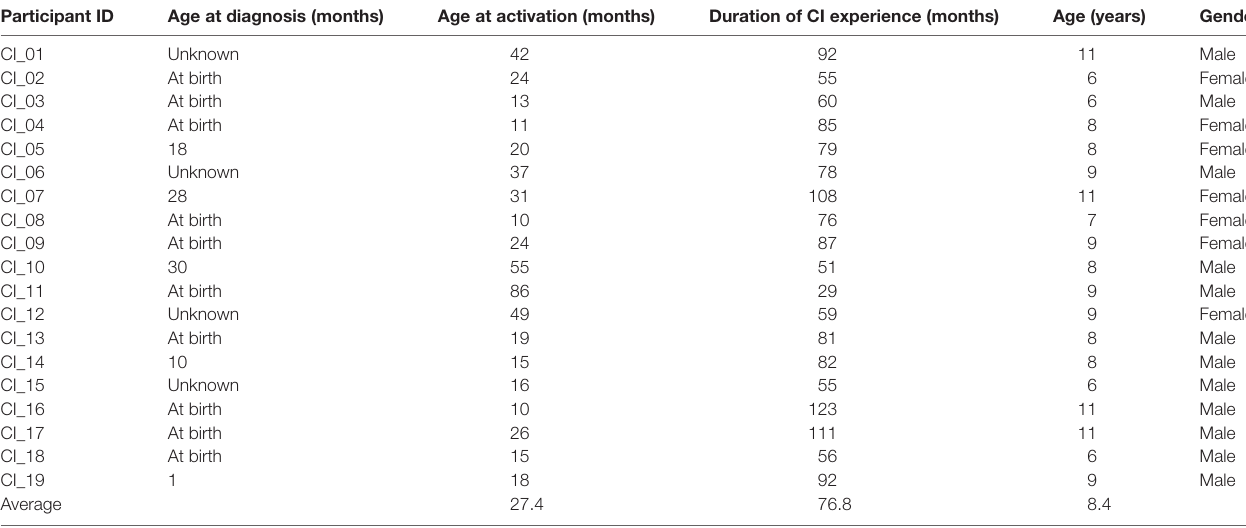
TABLE 1 | Summary of each Cochlear implant (CI) user’s age at diagnosis and CI activation, duration of CI experience, age, and gender ( N = 19). Participant ID